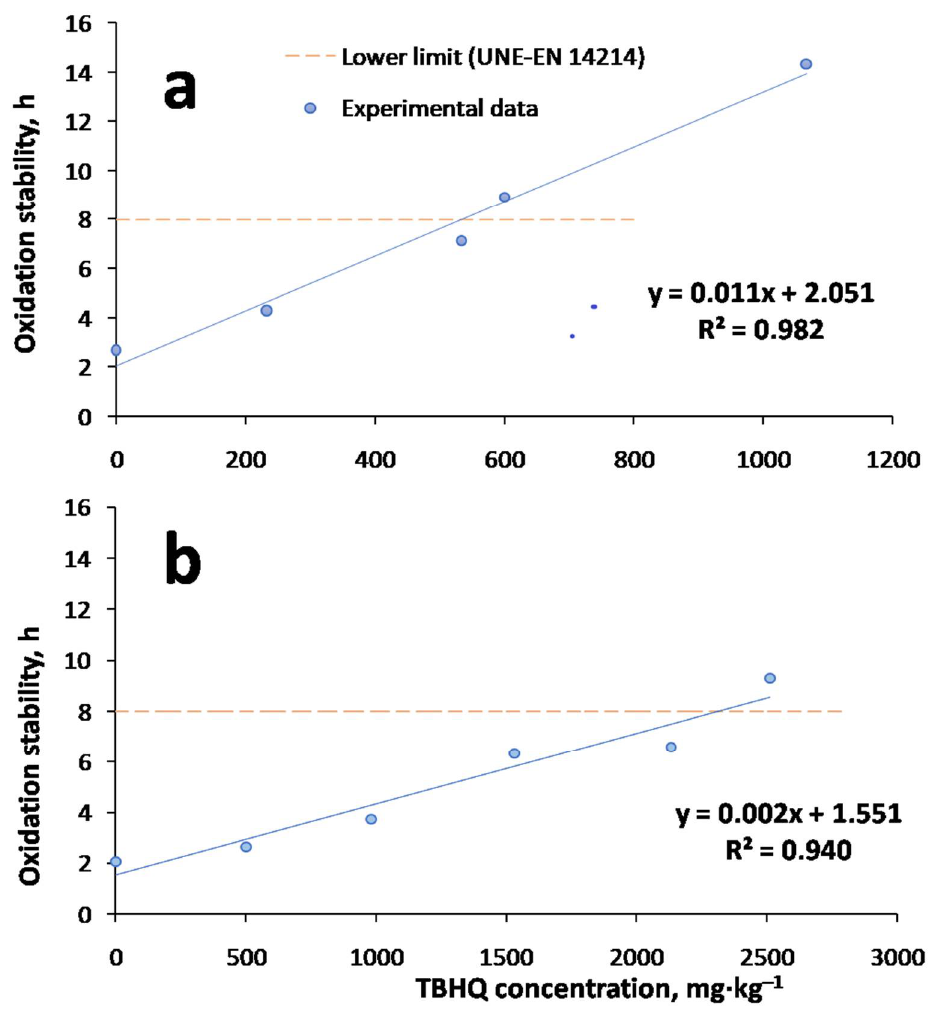
Figure 3. TBHQ addition and its effect on oxidative stability of ( a ) FOBD and ( b ) FOBL. Consequently, the optimum concentration of TBHQ for the FOBL (Op. TBHQ = 2300 mg·kg −1 or 2114 mg·L −1 ) was selected for oxidation experiments, included in the following